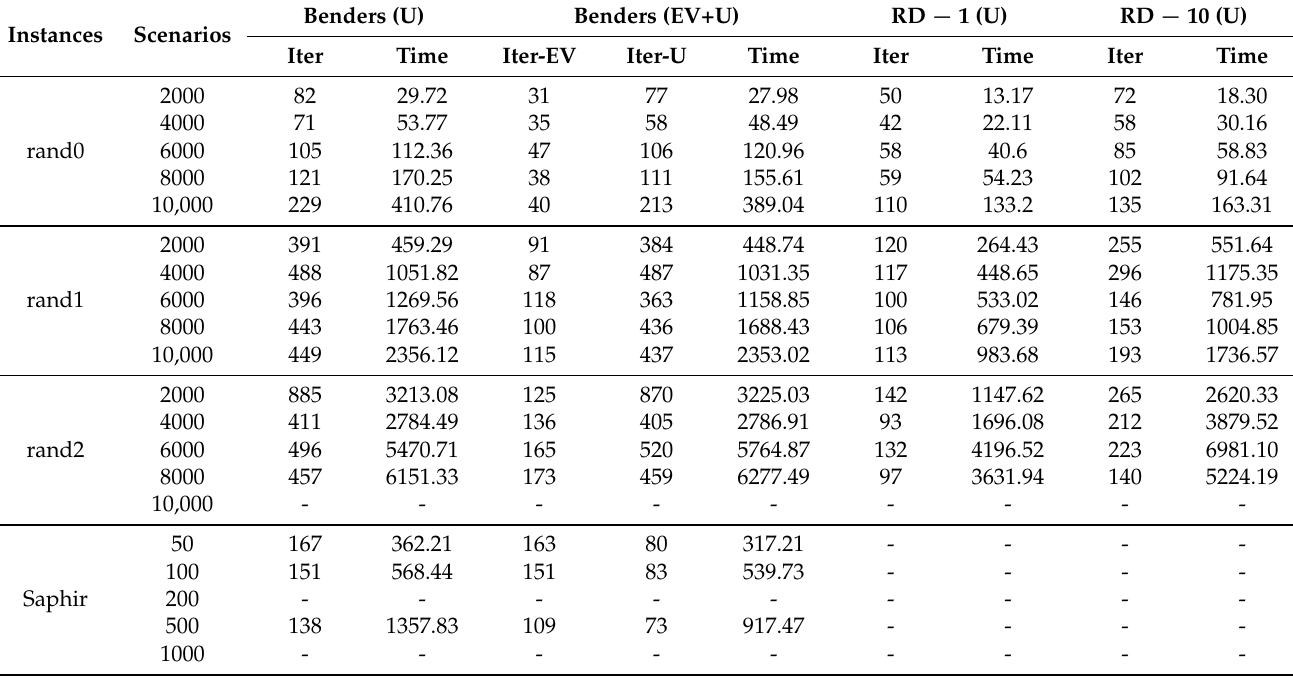
Table A9. Computational results for